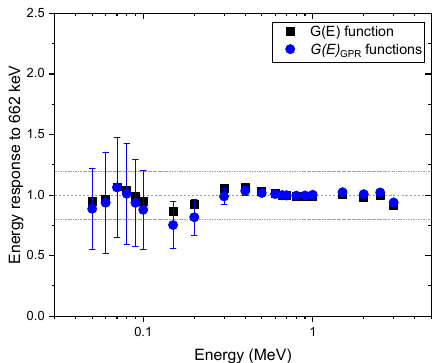
Figure 6. Comparison of energy response normalized to the energy of 622 keV, estimated with G ( E ) functions, and the G ( E ) function for the spectra obtained under the angle of incidence of 0 ° . The error bar shows a 95% confidence interval.